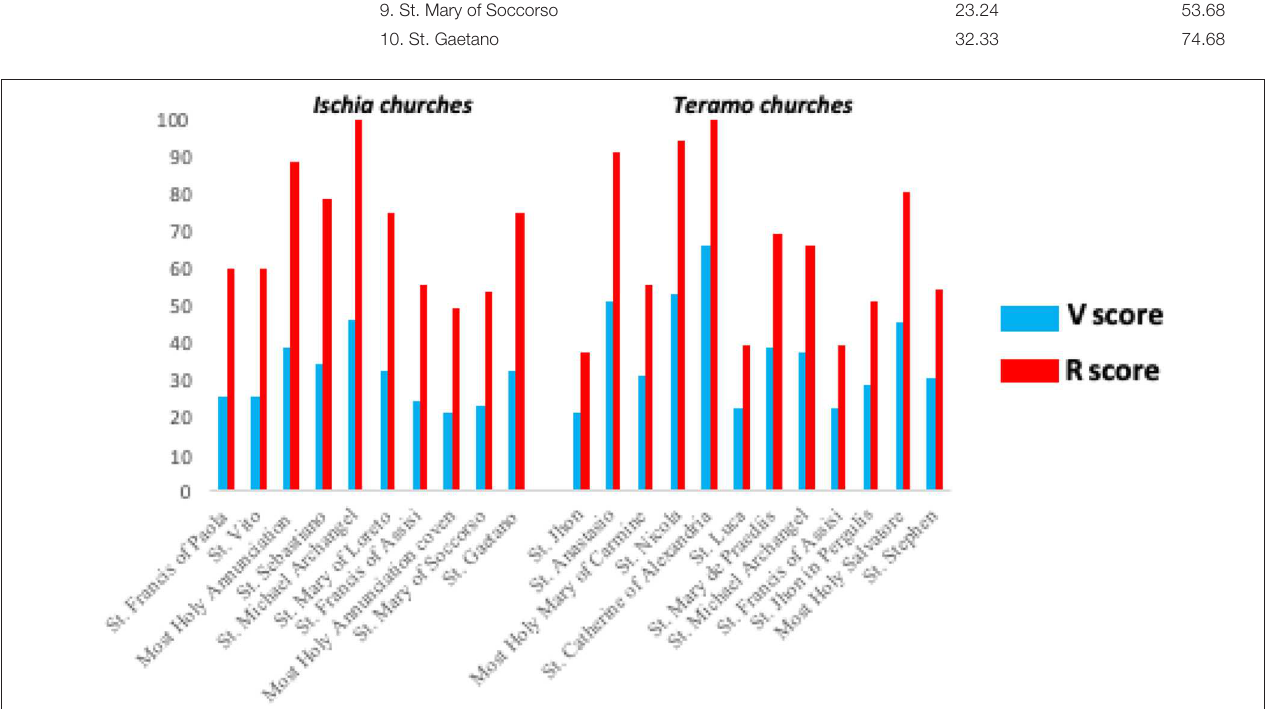
FIGURE 5 | Vulnerability ( V ) and the resulting seismic risk ( R )